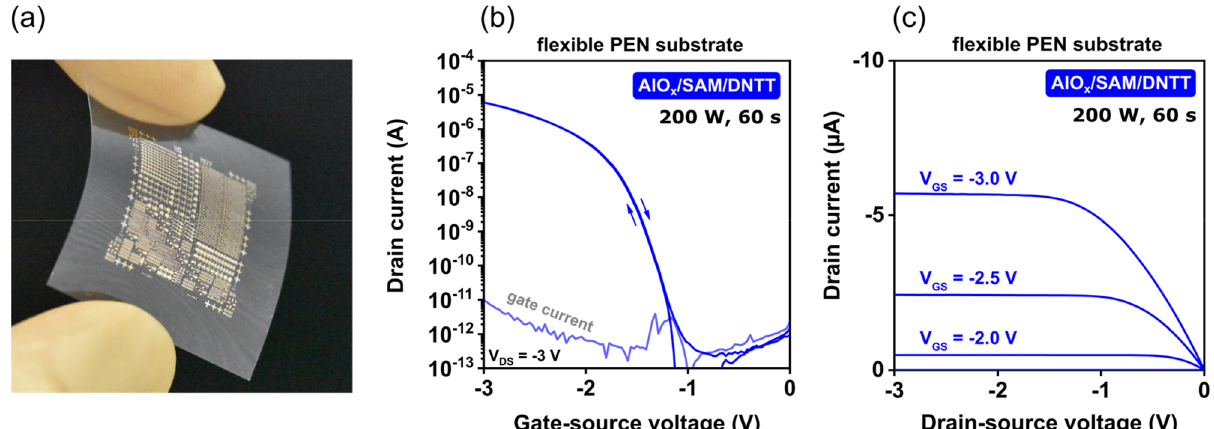
Figure 9. ( a ) Photograph of organic TFTs and circuits fabricated on a flexible polyethylene naphthalte (PEN) substrate. ( b ) Measured transfer and ( c ) output characteristics of a DNTT TFT with a channel length of 20 µm and a channel width of 100 µm on flexible PEN. The effective charge-carrier mobility is 2 cm 2 /Vs.